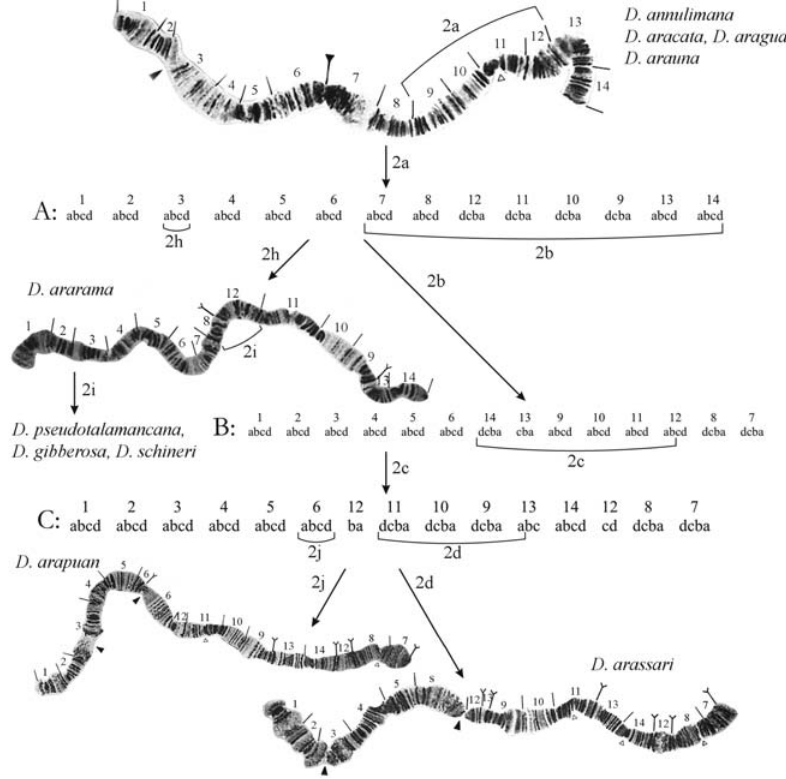
Figure 7 - Relationships among ten Drosophila species of the annulimana group based on the inversions observed in chromosome 2. A-C: hypothetical sequences:homozygousforinversions2a,2band2c,respectively.Thesubdivisions(abcd)havenocorrespondenceinthephotographicmapandwerein- cluded to facilitate